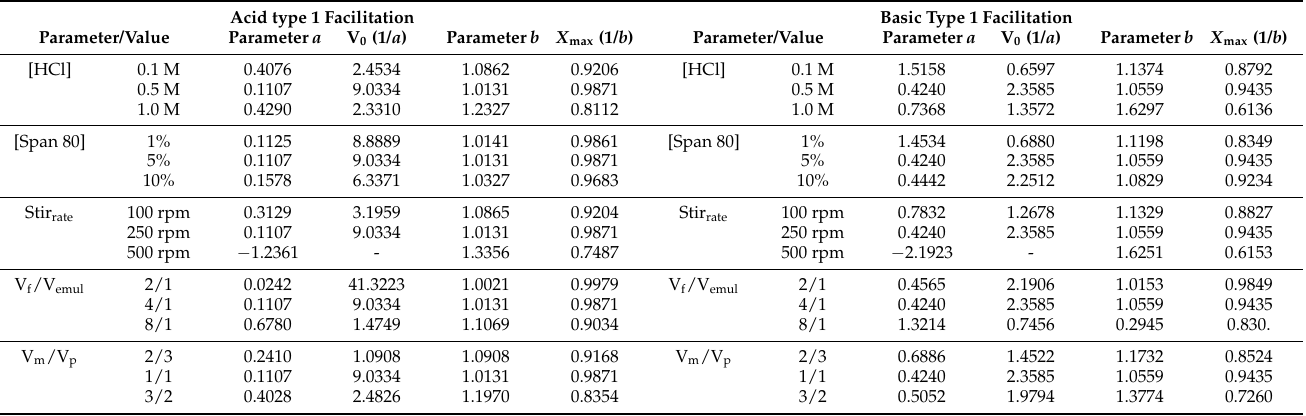
Table 2. Behnajady kinetic constants ( a , b ), their derived parameters initial removal rate (V 0 ) and maximal removal conversion ( X max